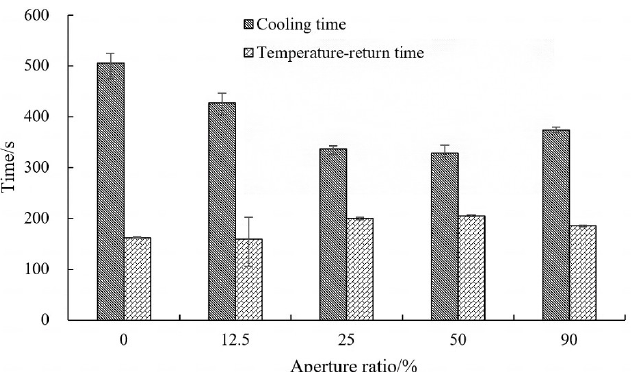
Figure 6. The influence of different aperture ratios on the cooling and temperature-return